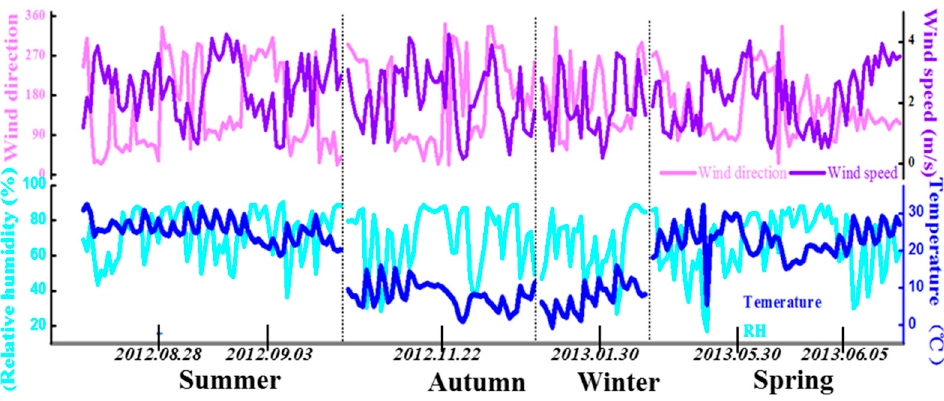
Figure 1. Location of sampling site in Nanjing, Jiangsu Province, the eastern China.